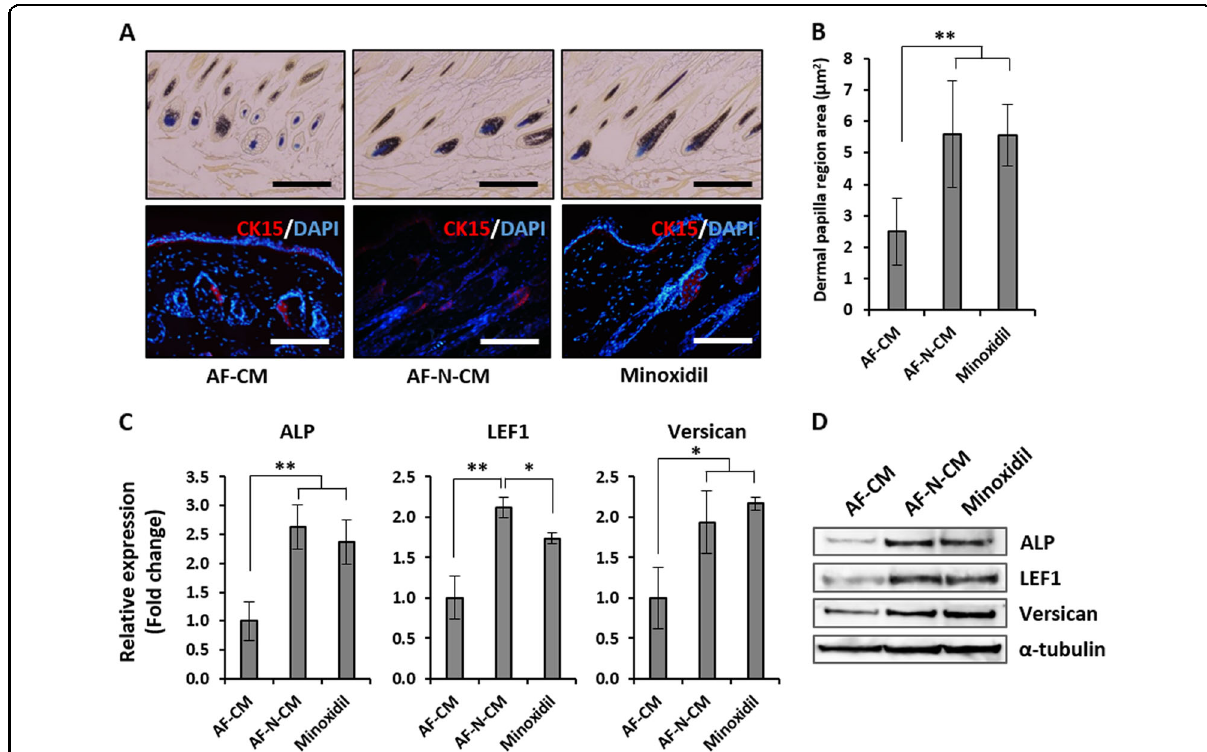
Fig. 6 Histological analysis of amniotic fl uid – derived mesenchymal stem cell overexpressing Nanog (AF-N-MSC) – derived conditioned media (AF-N-CM)-treated dorsal skin. a Expression patterns of the structural indicators at 5 days post-treatment: AP for hair follicle dermal papilla cell population (top) and CK15 for bulge stem cells (bottom). Quanti fi cation of the AP-positive dermal papilla region (right). Scale bar, 200 µm. b Quanti fi cation of the hair follicle dermal papilla region area ( μ m 2 ) determined by ImageJ. c Expression of hair growth markers (ALP, LEF1, and Versican) in AF-CM, AF-N-CM, and minoxidil treatments, as determined by quantitative real-time reverse transcriptase – polymerase chain reaction. d Protein levels of ALP, LEF1, and Versican in AF-CM, AF-N-CM, and minoxidil treatments, as determined by western blot. Data are represented as the mean ± SD ( n = 3). * p < 0.05, ** p <